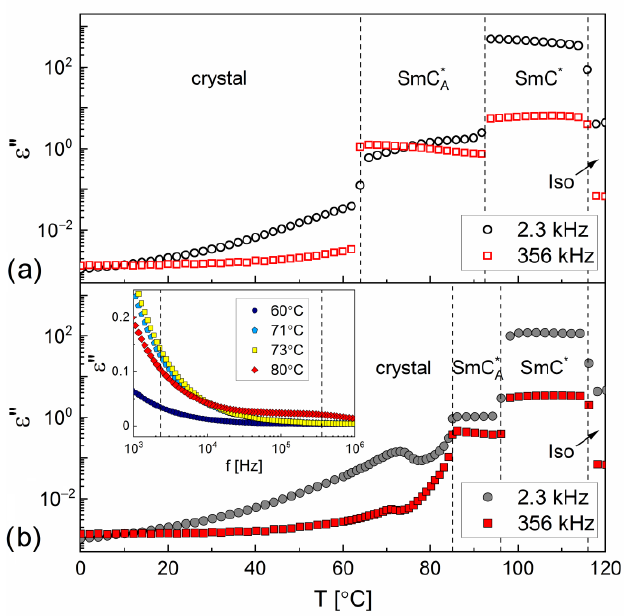
Figure 13. Imaginary part of the dielectric permittivity at chosen frequencies vs. temperature on cooling ( a ) and heating ( b ) for the thick (80 μm) sample of 4FF. The inset in ( b ) shows the absorption part close to the melting temperature and vertical lines denote frequencies chosen in the main panels.